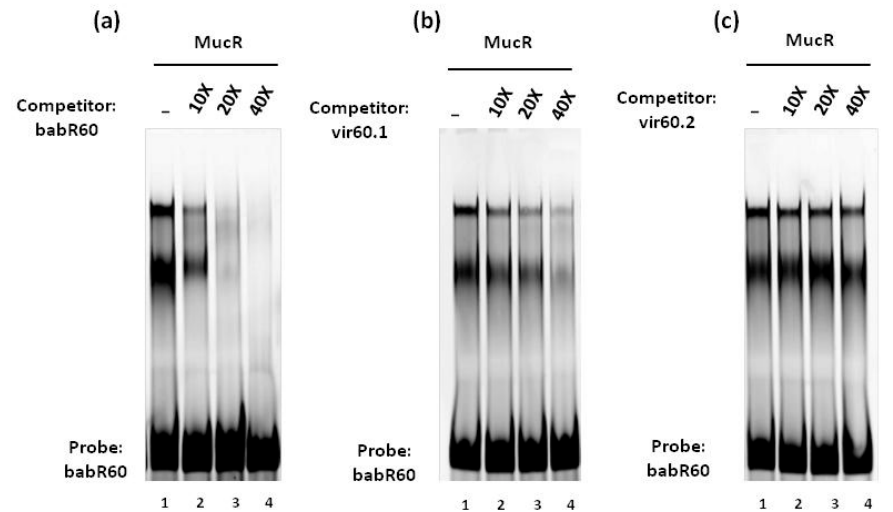
Figure 5. MucR binds with higher affinity to its target site in the babR promoter than it does to its target site in the virB promoter. Competition assays of MucR binding to babR60 using ( a ) babR60, ( b ) vir60.1 and ( c ) vir60.2 as competitors. The amount of excess of each competitor compared to the amount of probe is indicated at the top of the lanes.